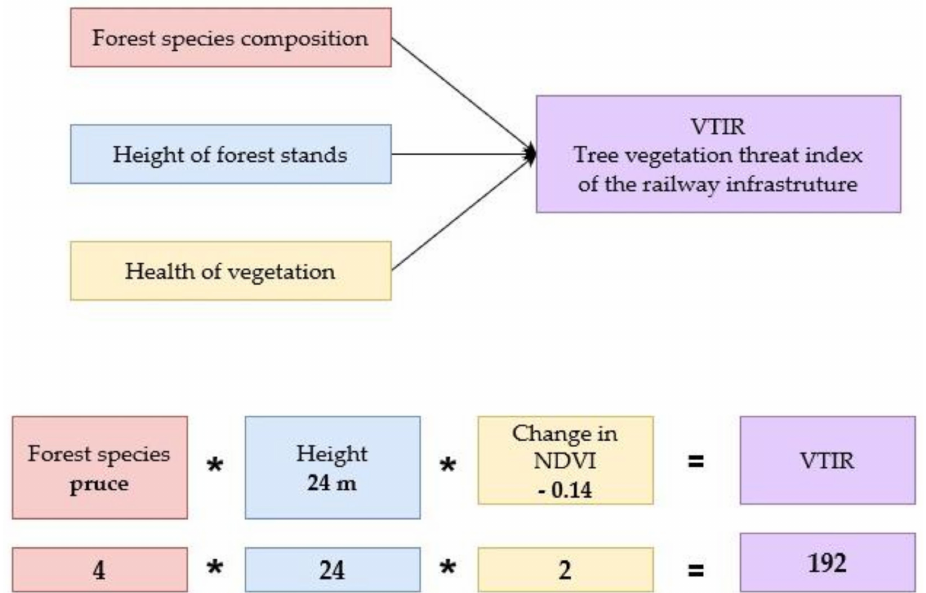
Figure 12. Example of calculation of the vegetation threat index for one pixel.